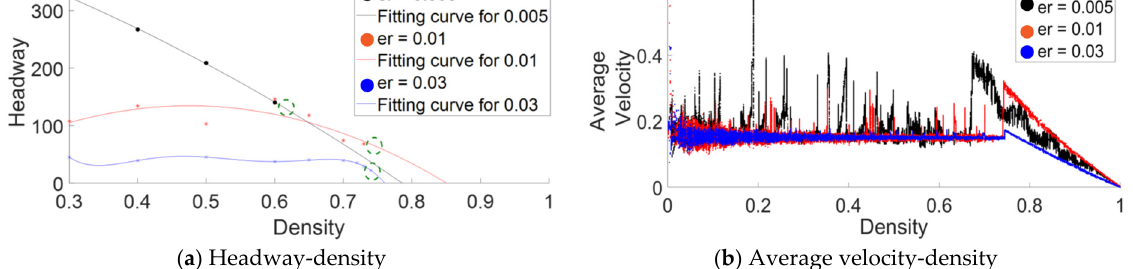
Figure A1. ( a ) Headway ( cells )-density and ( b ) average velocity ( cells / time step ) -density for different r e values are presented in order to predict and verify the rise-up phenomenon. In the headway-density plot, the averages of the distance headways measured of all of the platoons at low to medium density are plotted against the density at the time of measuring headways. The fitting curves based on the above mentioned low to medium density data are also presented to predict headways at higher densities. Using the predicted value of headway (Table A1) at which rise-up is hypothesized and fitting curves, we have calculated the density at which rise-up is expected (indicated by a dotted circle on the fitting curve). In ( b ) average velocity from ATM simulations is presented against density to verify the rise-up phenomenon. (Simulation scenario: L = 1000 cells , σ sat = 80 p units / cell , v min = 0.15cells/ time step , τ = 1 p units / time step )